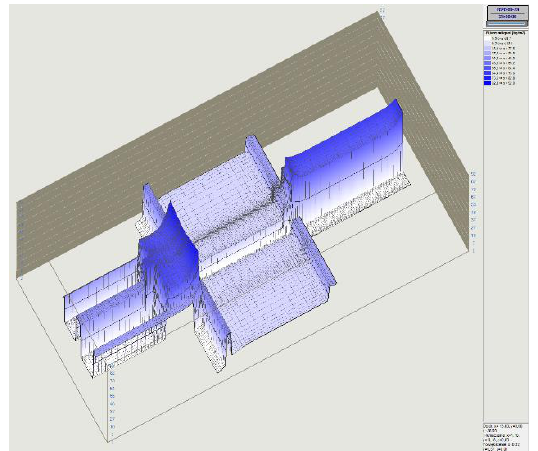
Figure 32. Visualisation of changes in water content for the analysed section, assumed for the alternative with internal insulation after 1 year.